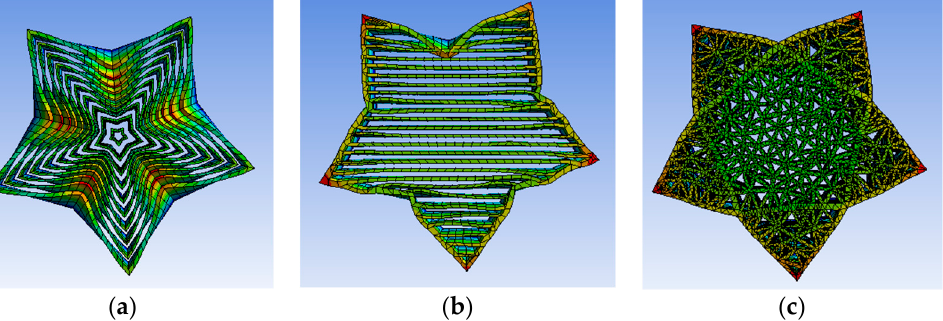
Figure 9. Finite element simulation diagram. ( a ) Contour offset filling; ( b ) straight lines filling; ( c ) Delaunay triangulation filling. Table 3. Transverse displacement change table.